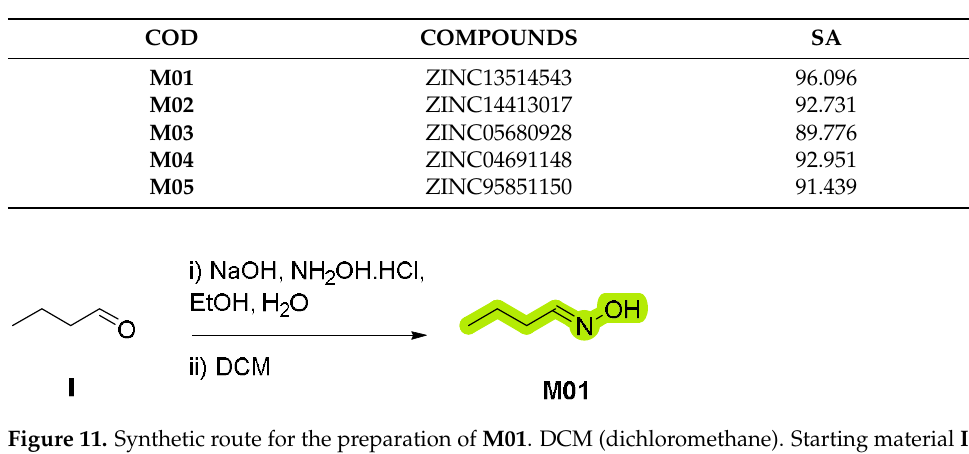
Figure 12. Theoretical synthetic route for the preparation of M02 . Starting material IV is commer- cially available. Furthermore, we designed a secondary strategy based on the previous work of C. Berini et al. [151]. Firstly, nitrone VII could be furnished by condensation between hy- droxylamine VI and acetaldehyde with magnesium sulfate in DCM. Eventually, the nu- cleophilic addition of pyrrole to intermediate VI I using HCl in MeOH would originate the target compound (Figure 13).